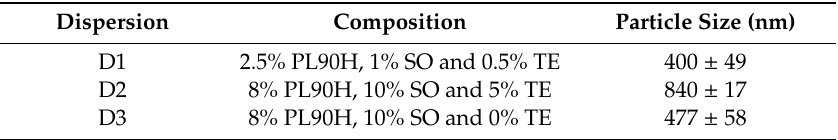
Table 2. Composition (wt.%) of the prepared aqueous dispersions with their particle sizes.